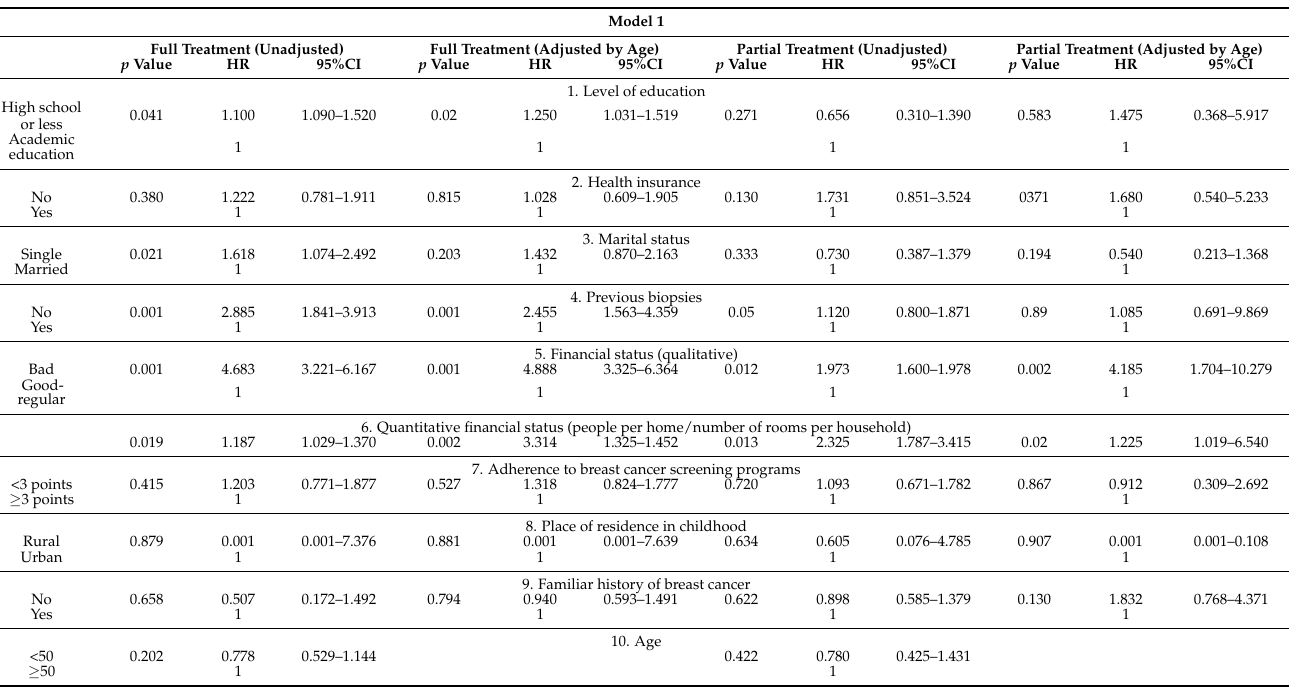
Table 3. Multivariate cox regression model of breast cancer–specific survival, stratifying by the course of treatment.